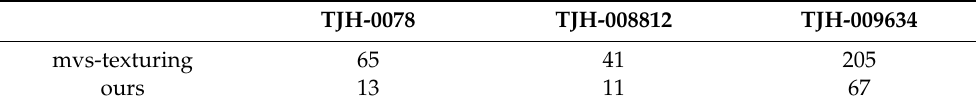
Table 2. Statistics of texture-mapping errors of mvs-texturing and ours on three datasets. The fewer the errors, the better the